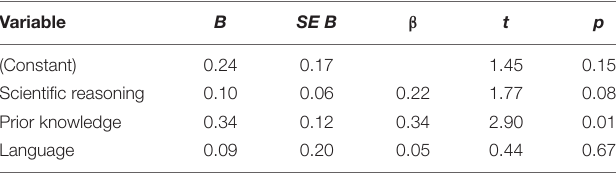
TABLE 11 | Regression analysis summary for scientific reasoning, prior knowledge, and language predicting describing in observation